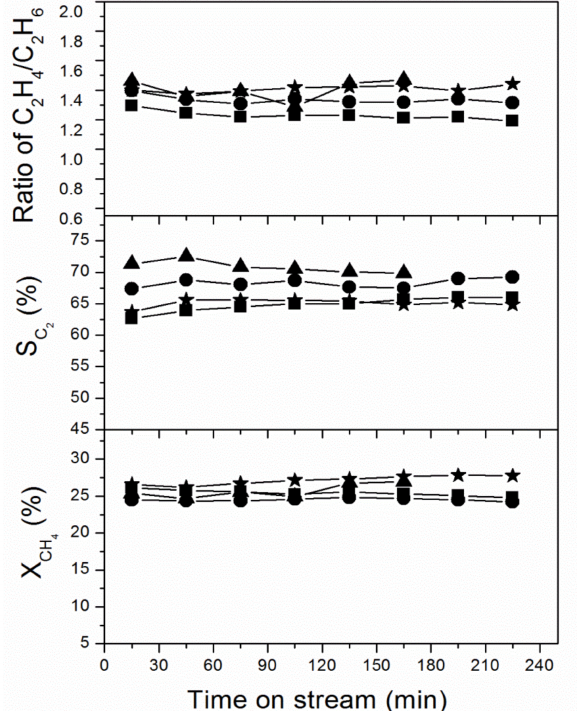
Figure 6. Influence of feedstock composition on methane conversion, selectivity to C 2 and ethy- lene/ethane molar ratio. Reaction conditions: T = 1053 K; GHSV = 11,550 cm 3 · g − 1 cat · h − 1 ; m cat = 400 mg; total flow rate = 77 cm 3 · min − 1 ; molar ratio of CH 4 :O 2 = 3.3 (in all cases); V CH4 :V O2 :V He + CO2 + N2 = 14.4:4.3:58.3. Symbols: ( (cid:4) ) biogas 1 (as source of methane), ( (cid:78) ) biogas 2 (as source of methane), ( • ) mixture of CH 4 + CO 2 + O 2 + He, ( (cid:70) ) mixture of CH 4 + O 2 +